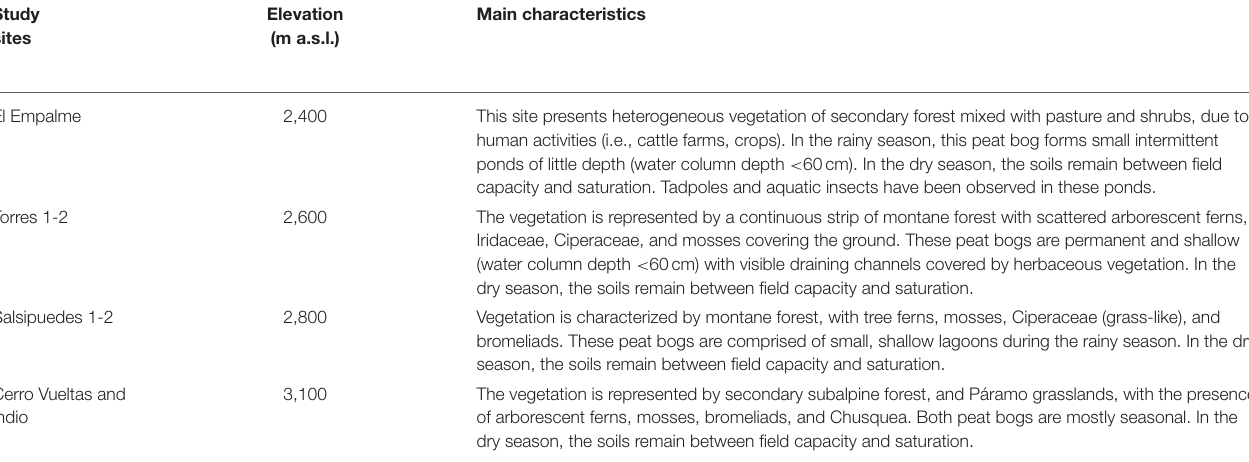
TABLE 1 | Summary of main vegetation and morphological characteristics of the study